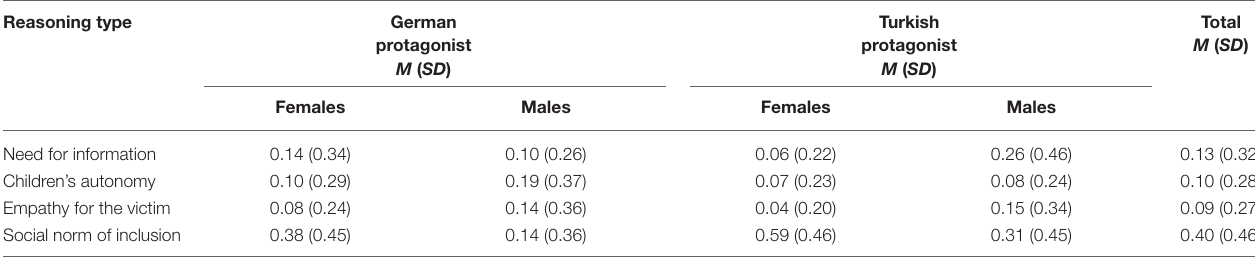
TABLE 3 | Proportional use of justifications for likelihood of intervention. Reasoning